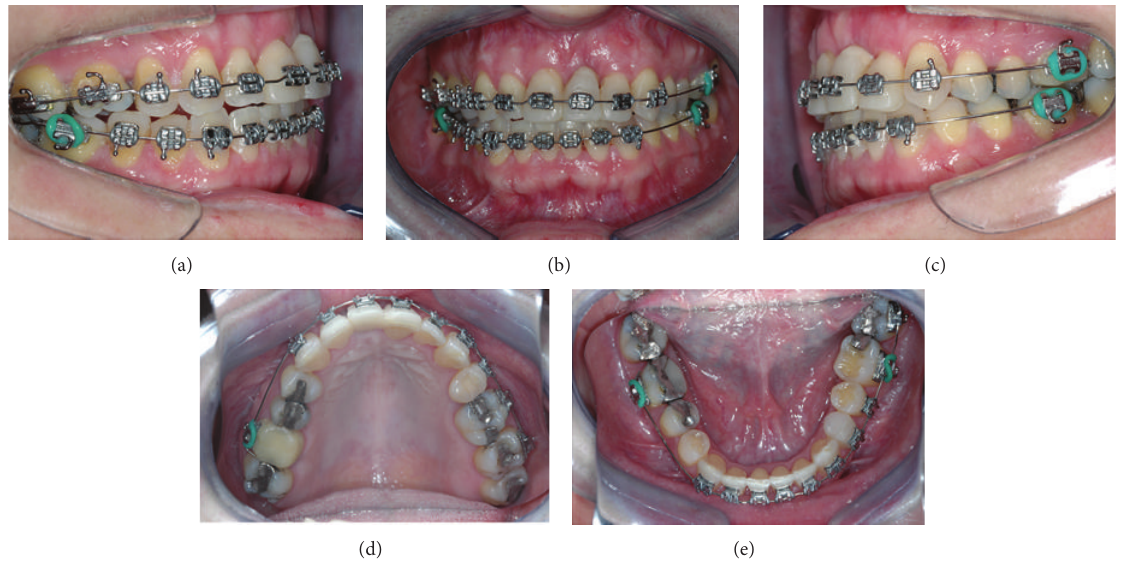
Figure 6: Posttreatment orthodontic movement showing acceptable